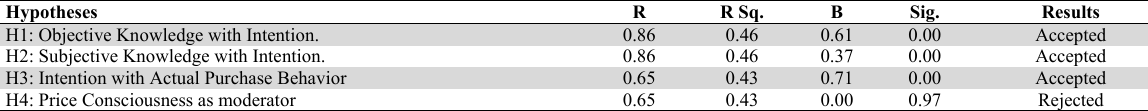
Research Findings and Hypothesis Testing